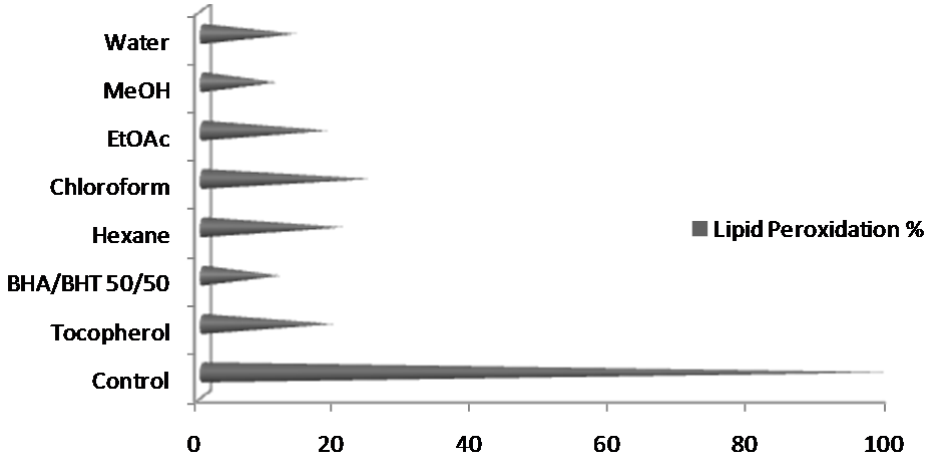
Figure 4. Lipid peroxidation in extracts of Artimisia annua leaves prepared in different